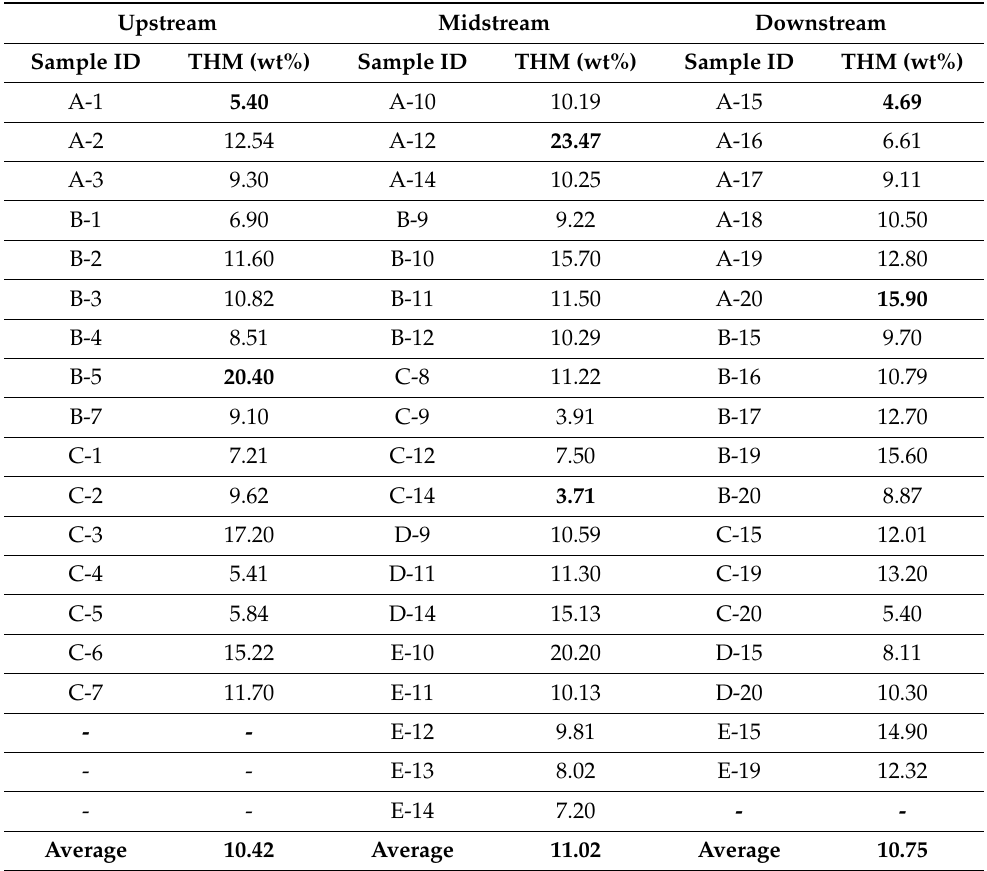
Table 1. THM contents (wt%) from the sand samples determined by float-sink analysis using bromoform. Samples were divided into upstream, midstream and downstream according to their location within the sampled area (Figure 1). Numbers in bold represent the lowest and highest THM contents within each sector. Upstream